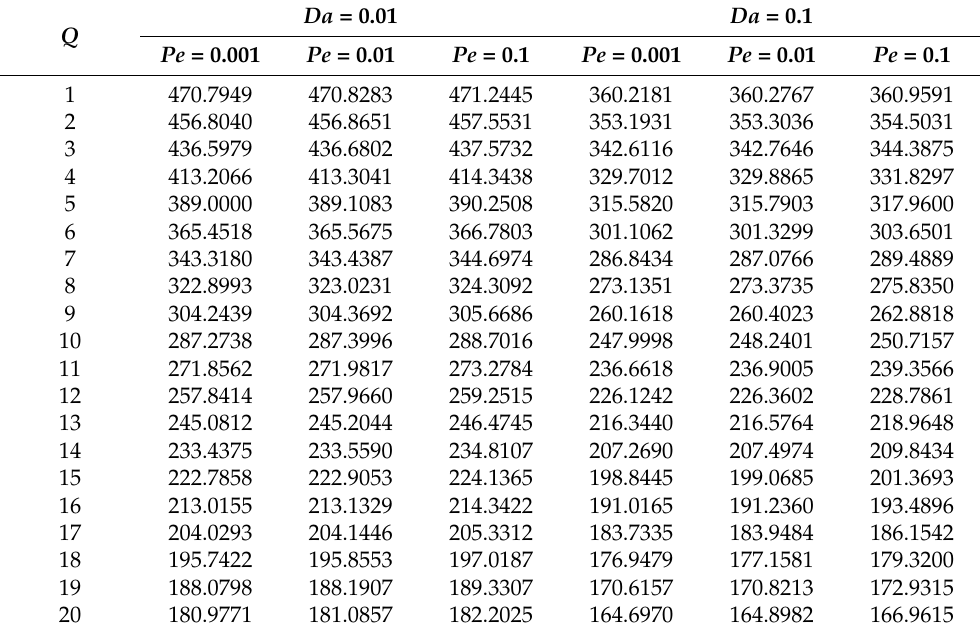
Table 3. Critical Rayleigh number for upward throughflow fixed at Ta =